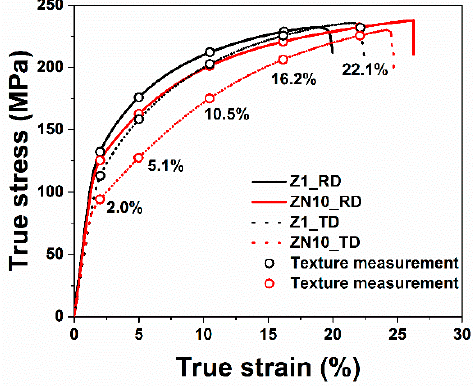
Figure 5. True stress- strain curves of Z1 and ZN10 along RD and TD.